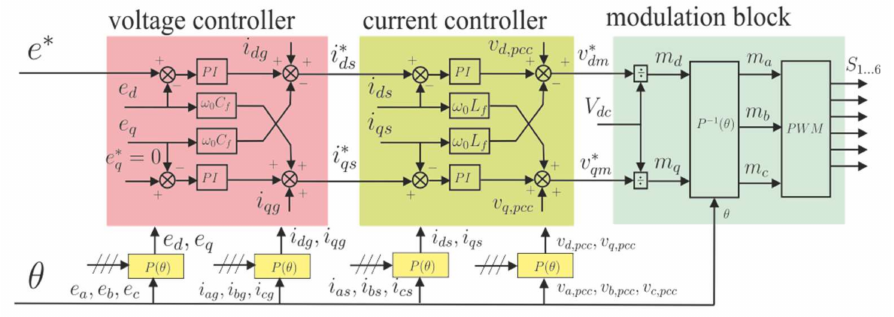
Figure 2. Grid-forming voltage and current control